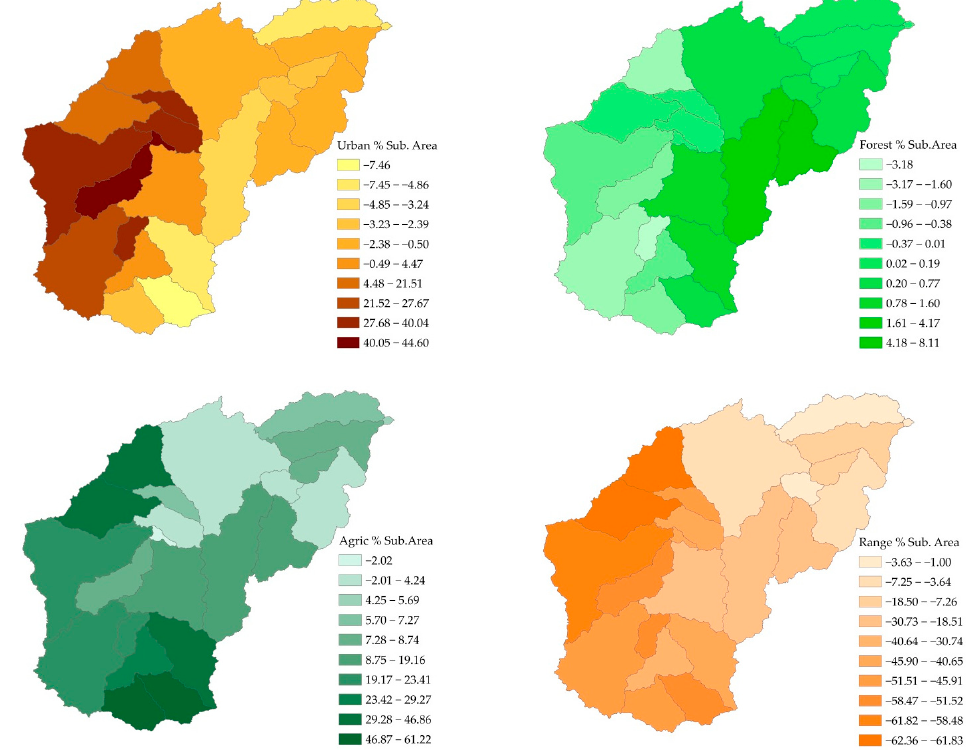
Figure 6. Spatial distribution of land use changes at the sub ‐ basinal scale between 2000 and 2013.